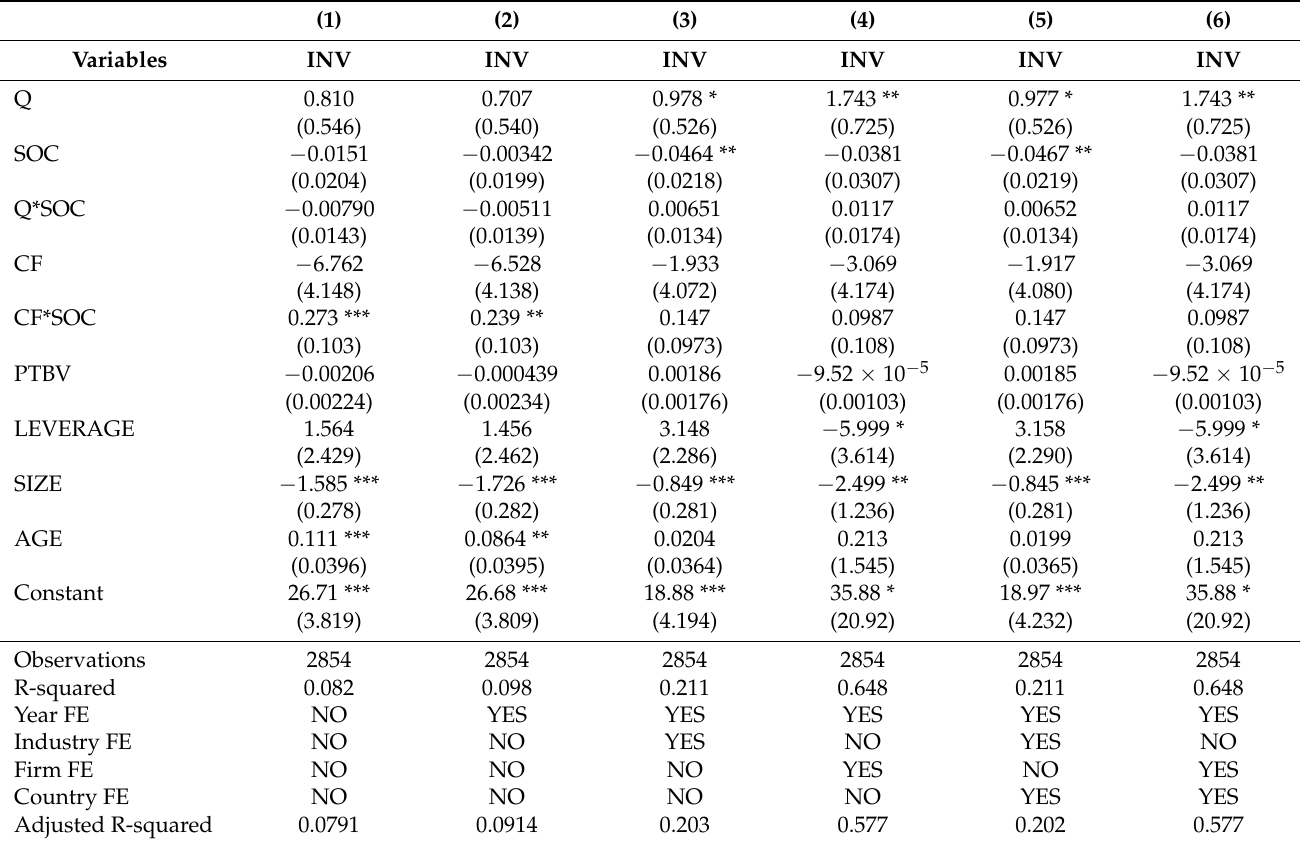
Table 4. Total social performance and investment